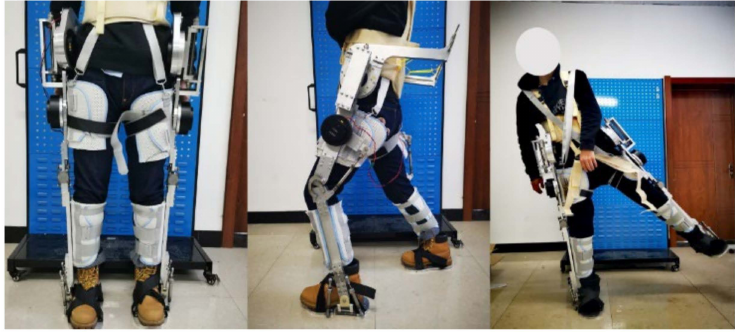
Figure 32. Wearing experiment of lower-limb exoskeleton rehabilitation